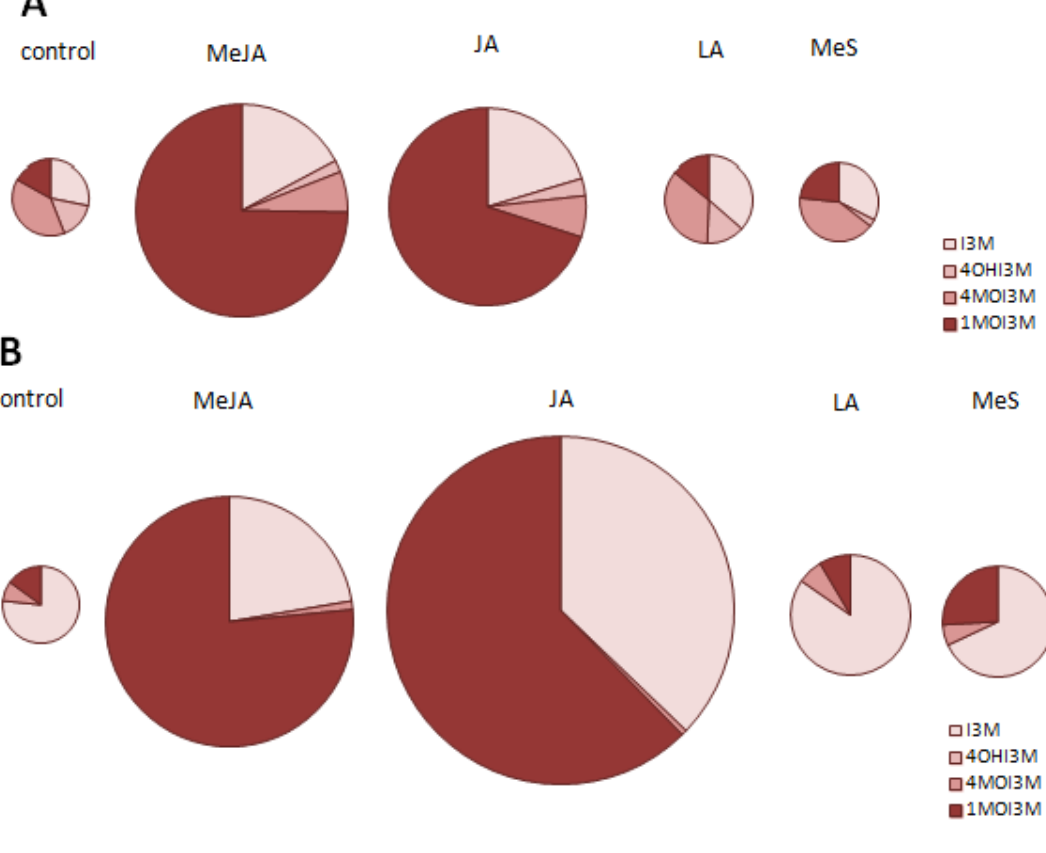
Figure 7. Individual glucosinolate levels as a percentage of the total indole glucosinolate level in sprouts and mature leaves. Percentage in sprouts ( A ) and leaves ( B ) are